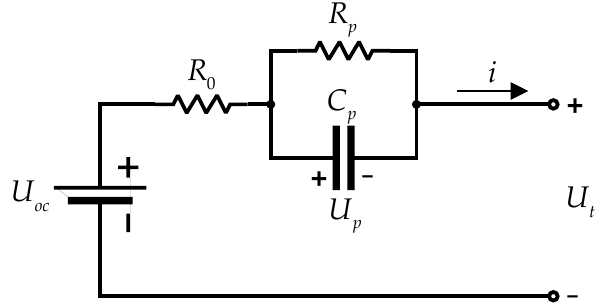
Figure 1. Schematic diagram of a first-order RC model.